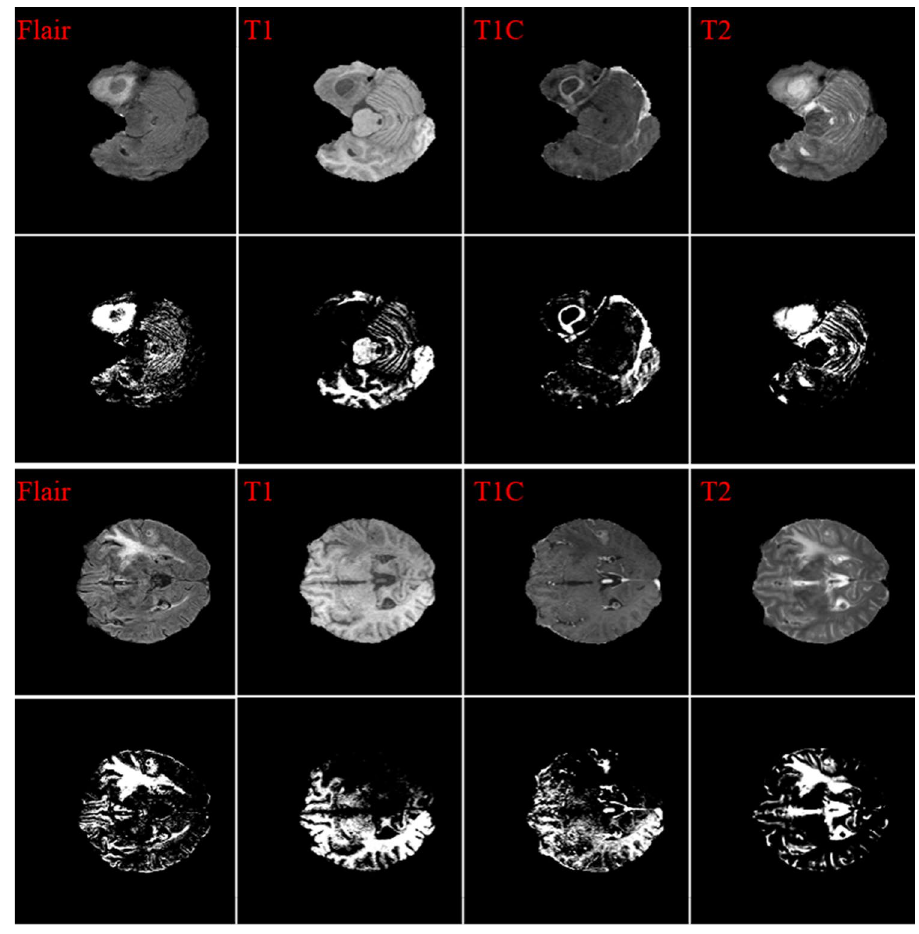
Figure 1. Two sets of four MRI modalities and their corresponding Z-Score